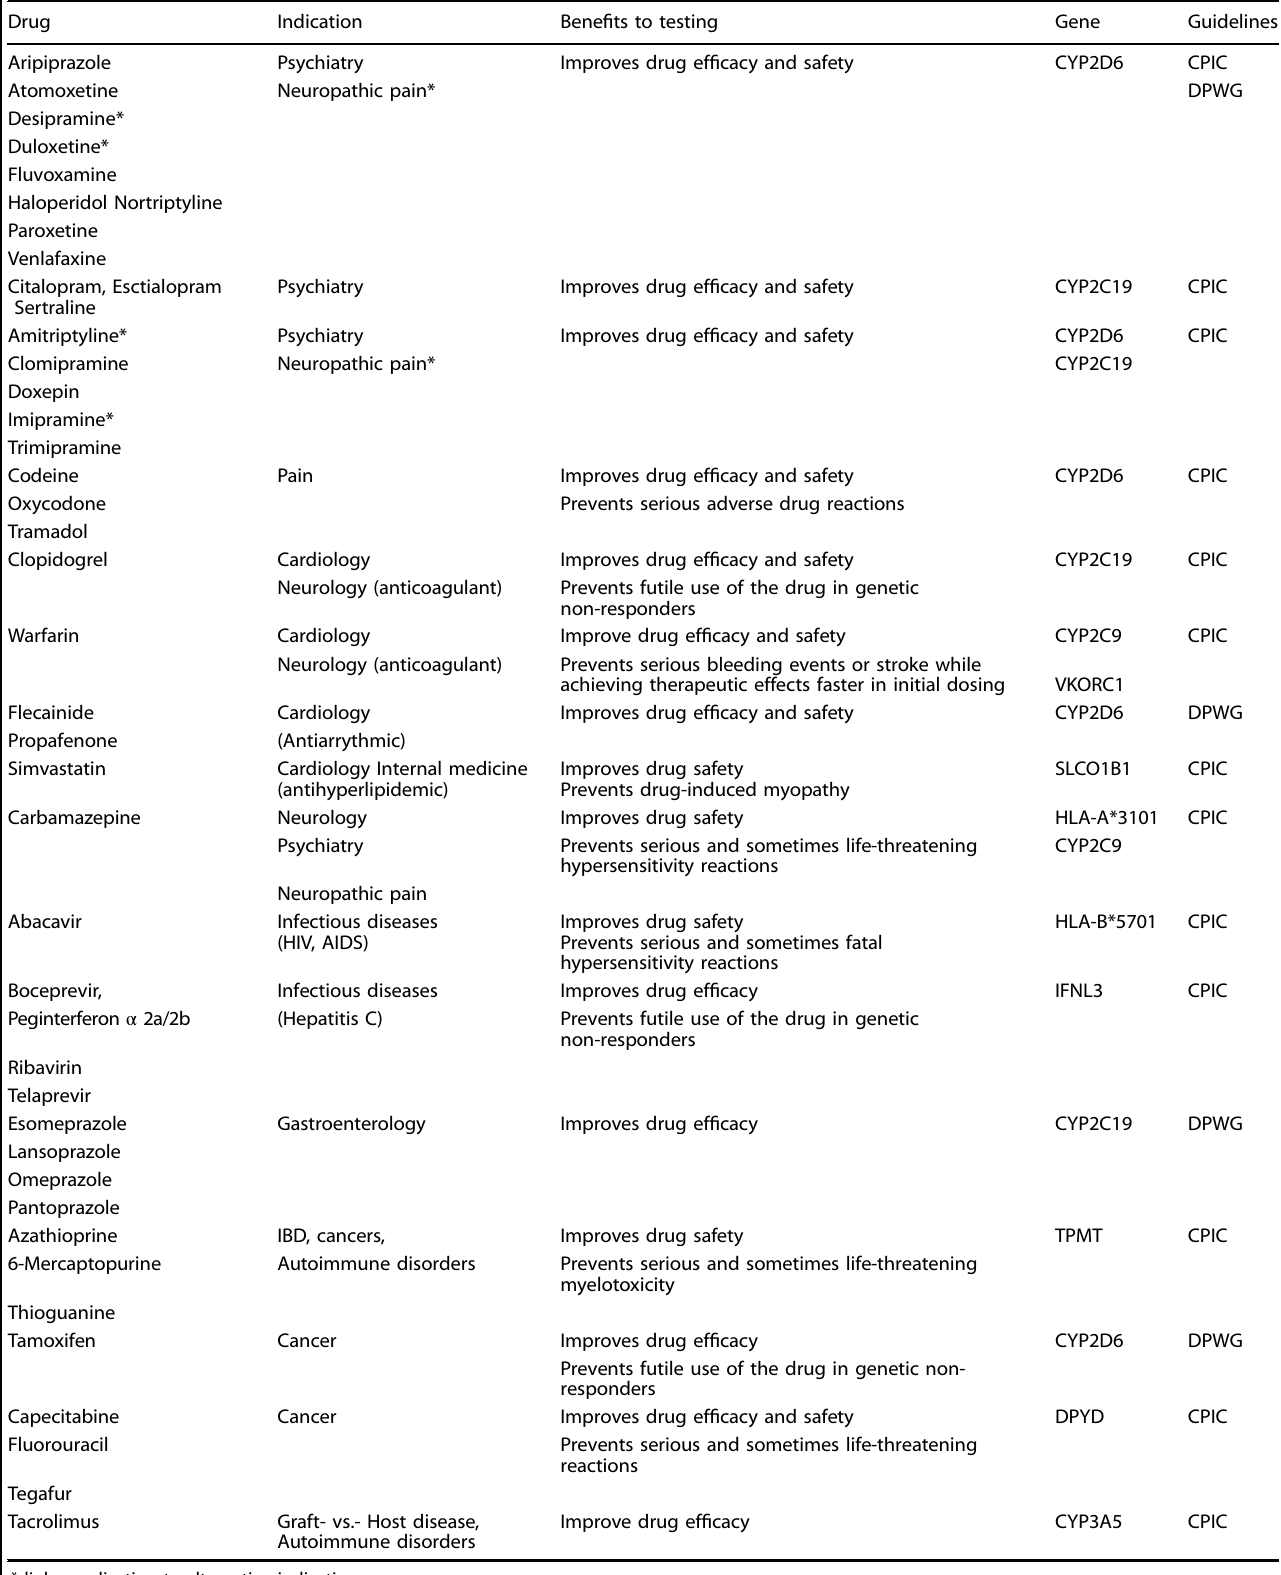
Table 2. Overview of interrogated drug-gene pairs